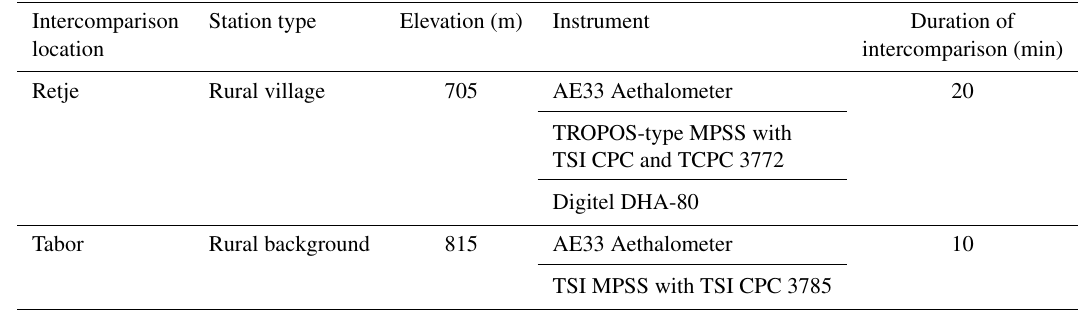
Table 2. Air quality measurement stations with the “reference” aerosol instruments at the study